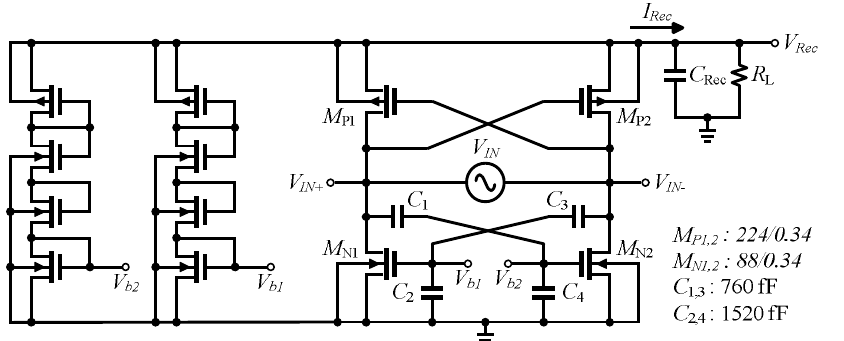
Figure 19. Rectifier proposed in [41]. Reproduced with permission from M. A. Ghanad, IEEE Proceedings; published by IEEE, 2012. Figure 5. Proposed rectifier.